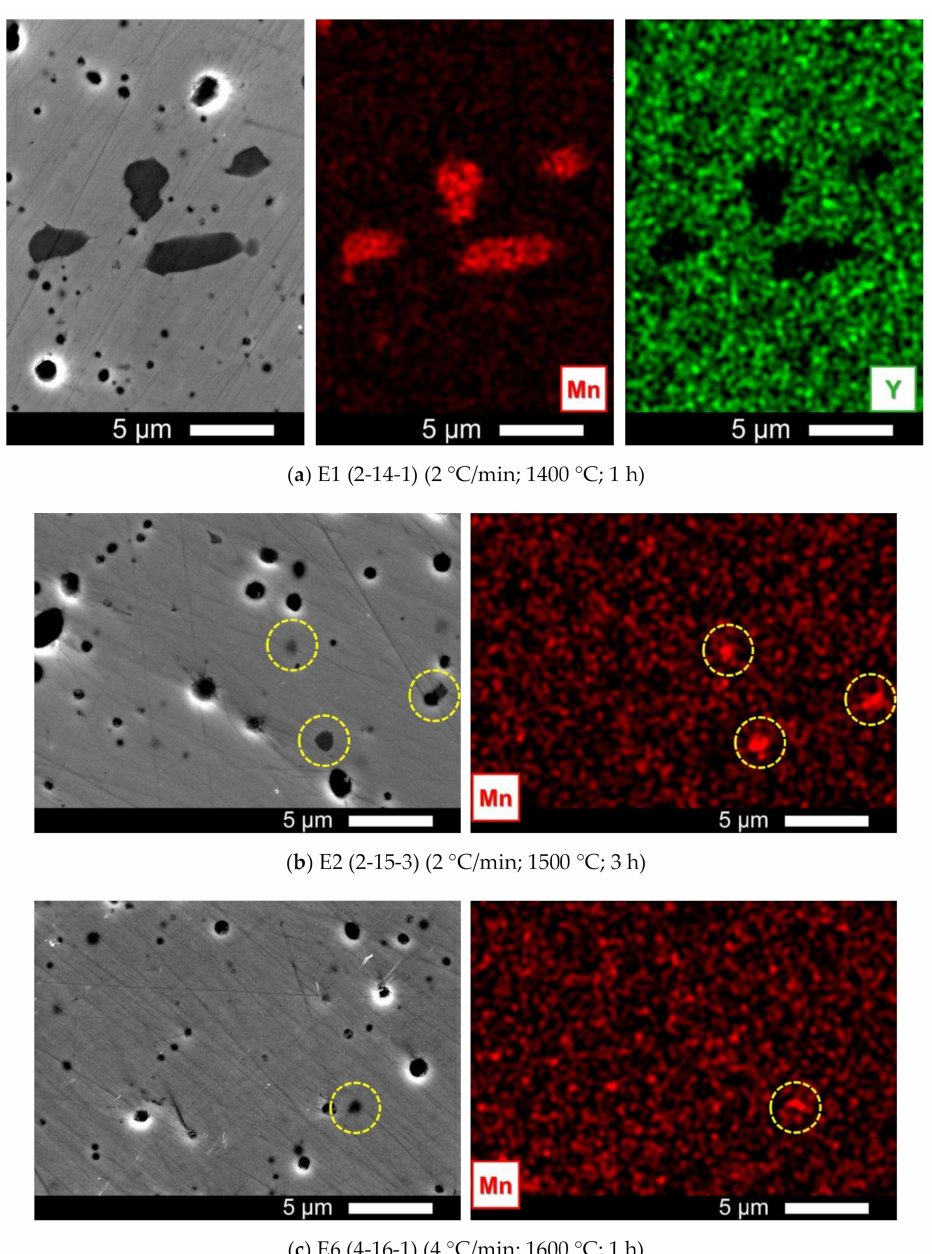
Figure 4. Scanning electron microscopy with Mn-rich precipitates identified by a darker shade and / or by EDS elemental mapping, for samples sintered at ( a ) 1400 ◦ C (E1 (2-14-1)), ( b ) 1500 ◦ C (E2 (2-15-3)) and ( c ) 1600 ◦ C (E6 (4-16-1)). Circles show a close correlation between dark spots of light elements and higher concentrations of